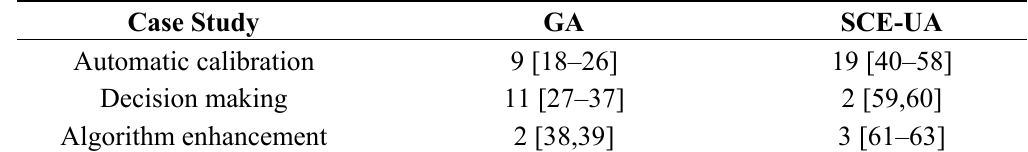
Table 1. Case studies of GA and SCE-UA algorithm application for the last five years